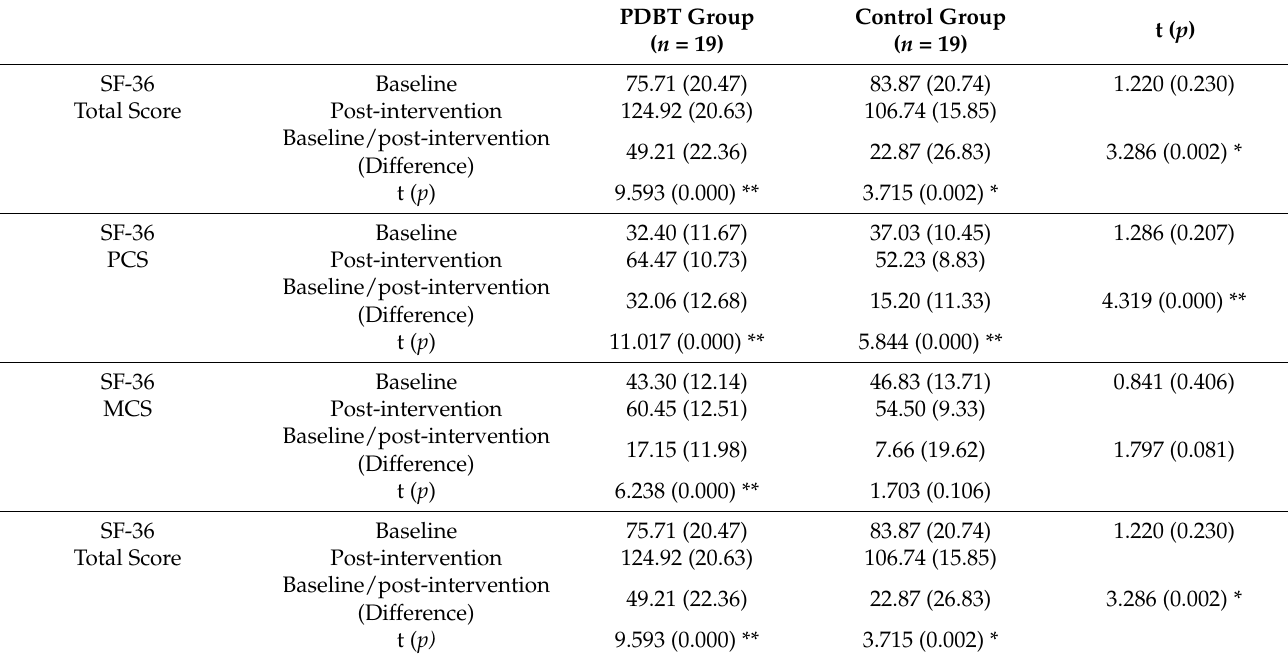
Table 4. Comparison of quality of life within and between the groups ( n =